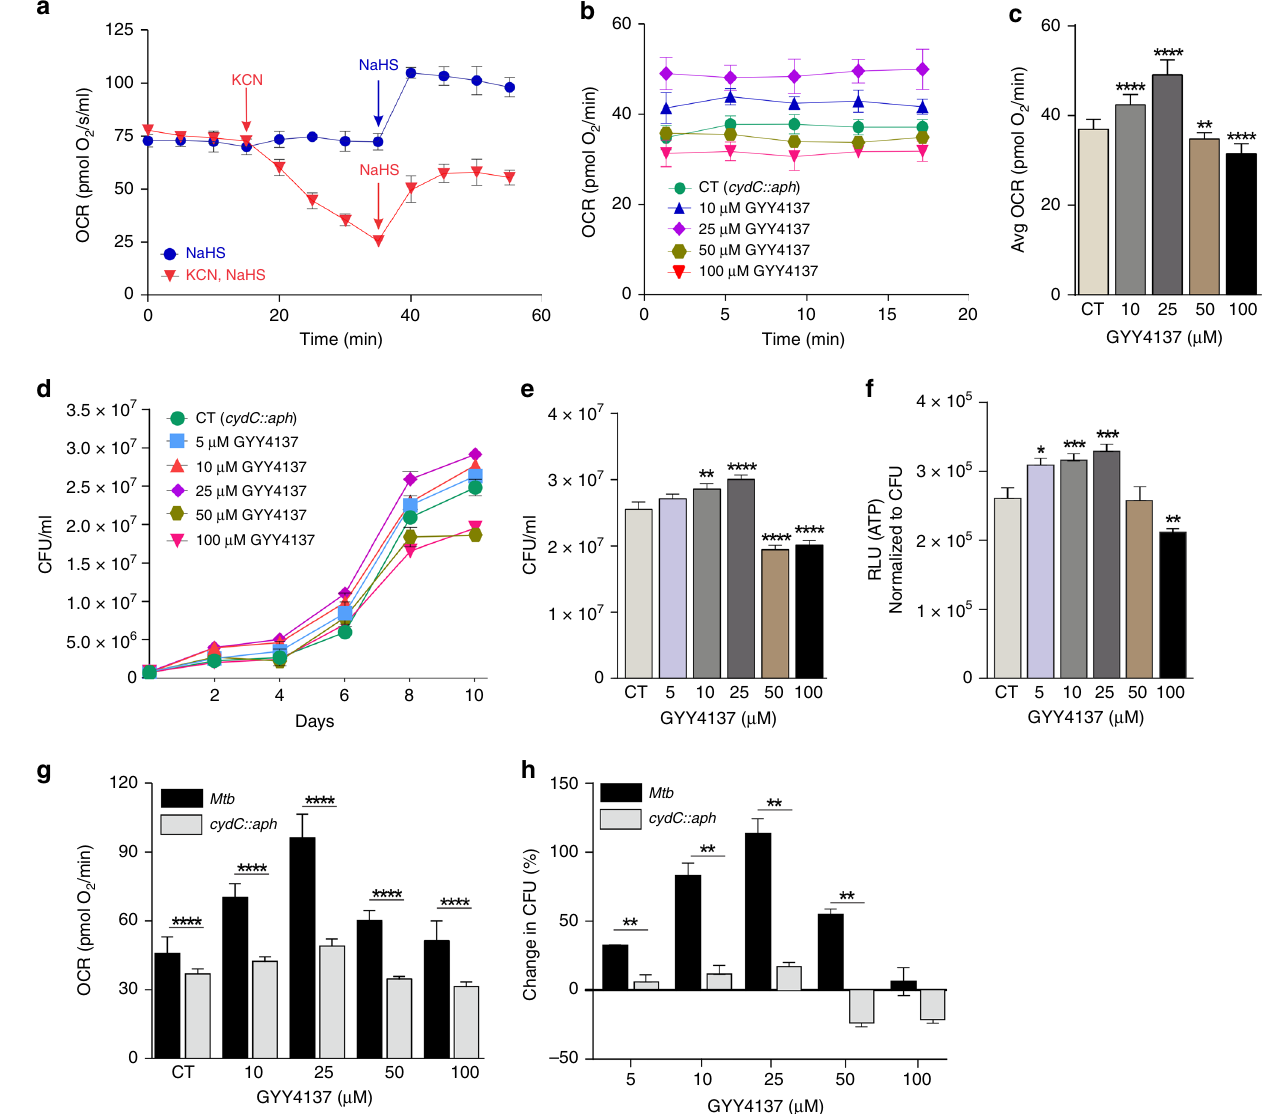
Fig. 4 H 2 S stimulates Mtb bioenergetics primarily through cytochrome bd -type quinol oxidase. a Representative OCR pro fi le of M. smegmatis (Msm) cells. Arrows indicate the time of addition of KCN (100 μ M) or NaHS (25 μ M) ( n = 5). b Representative OCR pro fi le and c average OCR of cydC::aph cells exposed to GYY4137 ( n = 12 − 18, data pooled from at least two independent experiments). d CFU-based growth pro fi le of cydC::aph cells following exposure to GYY4137. e Mean cydC::aph CFU values at day 10 of the growth analysis. f ATP levels in cydC::aph after 24 h exposure to GYY4137. Data ( d − f ) are representative of at least two independent experiments. g Comparison of the dose-dependent effect of GYY4137 on the OCR of Mtb and cydC::aph cells (from Figs. 2e and 4c). h Percent change in CFU of Mtb and cydC::aph ( e ) following exposure to increasing concentrations of GYY4137 (from Figs. 2b